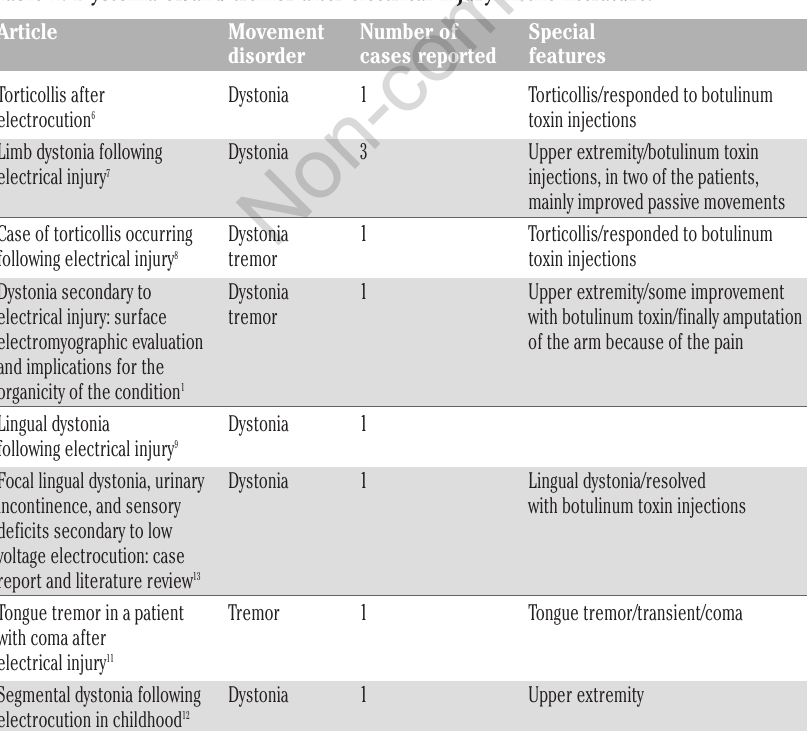
Table 1. Dystonia or/and tremor after electrical injury in the literature. Movement Number of Special disorder cases reported features Torticollis